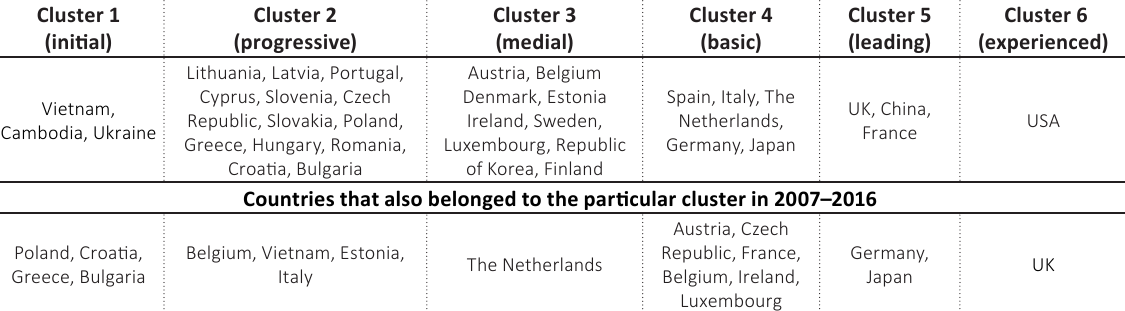
Table 1. Distribution of countries by clusters by